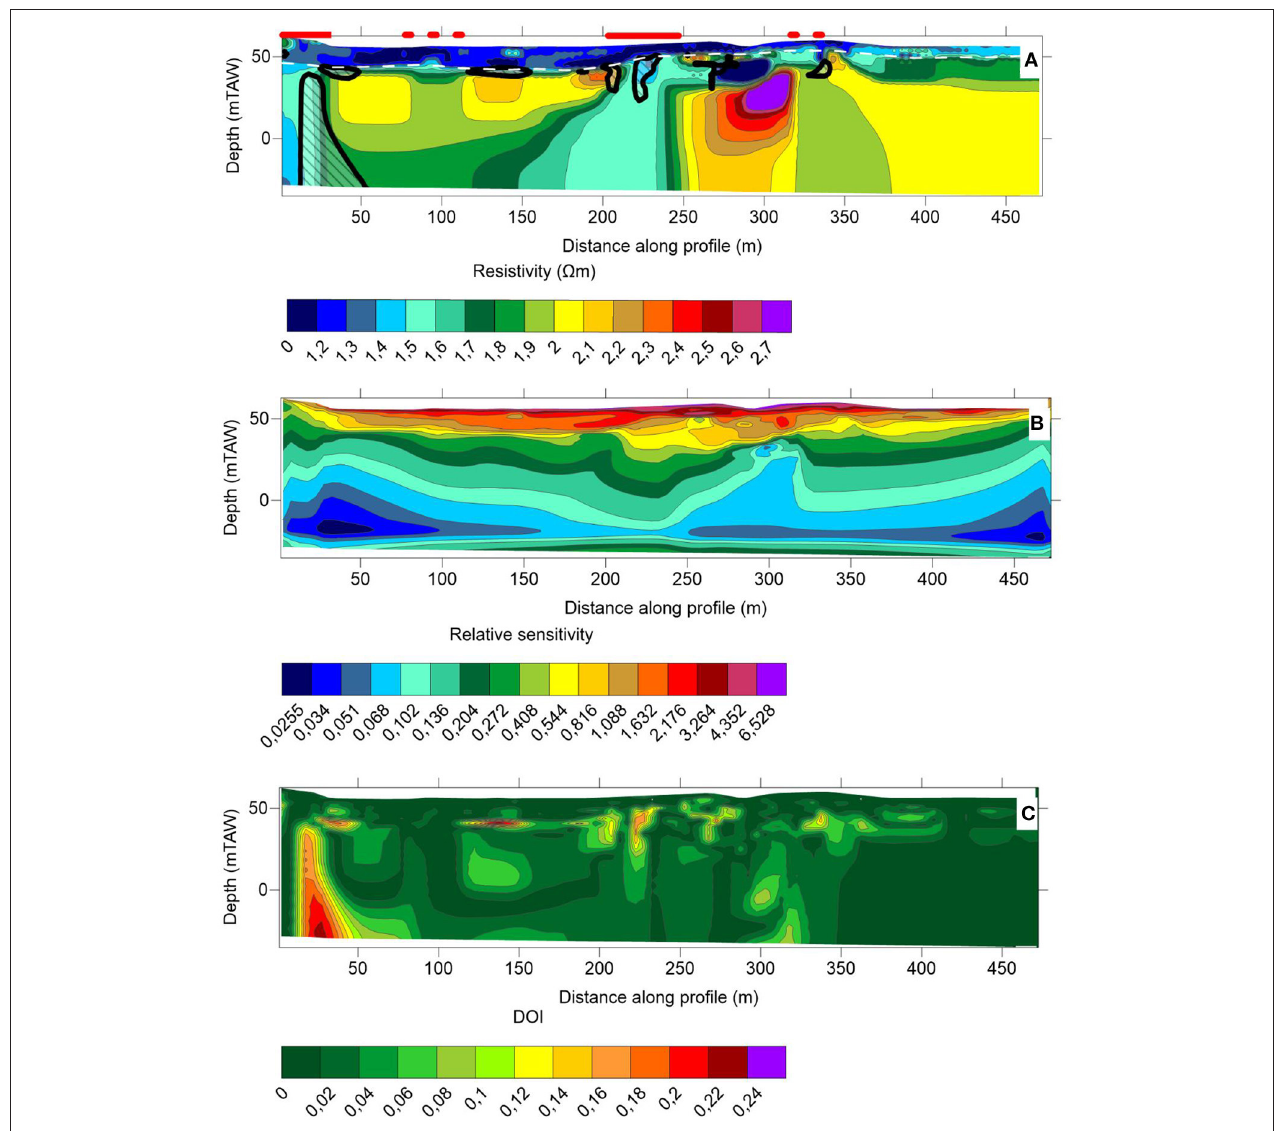
FIGURE 3 | Profile 1 (A) with sensitivity section (B) and DOI (C)